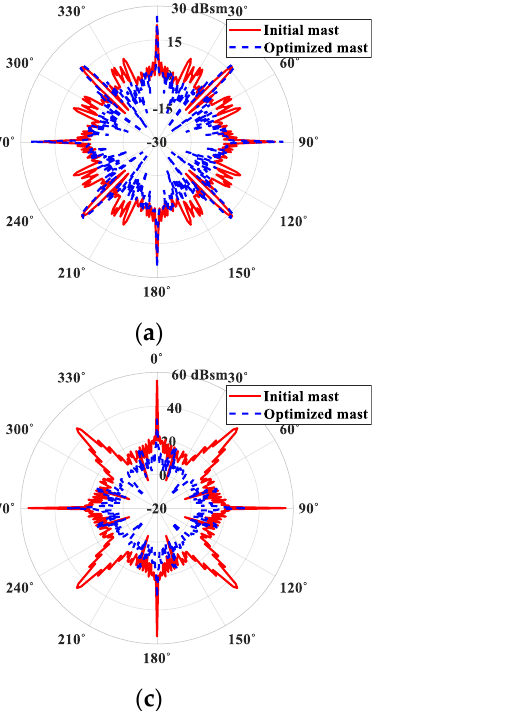
Figure 6. RCS pattern of the integrated mast in the azimuth plane in the L-band. ( a ) HH polarization at an elevation angle of 0°, ( b ) VV polarization at an elevation angle of 0°, ( c ) HH polarization at an elevation angle of 10°, ( d ) VV polarization at an elevation angle of 10°.